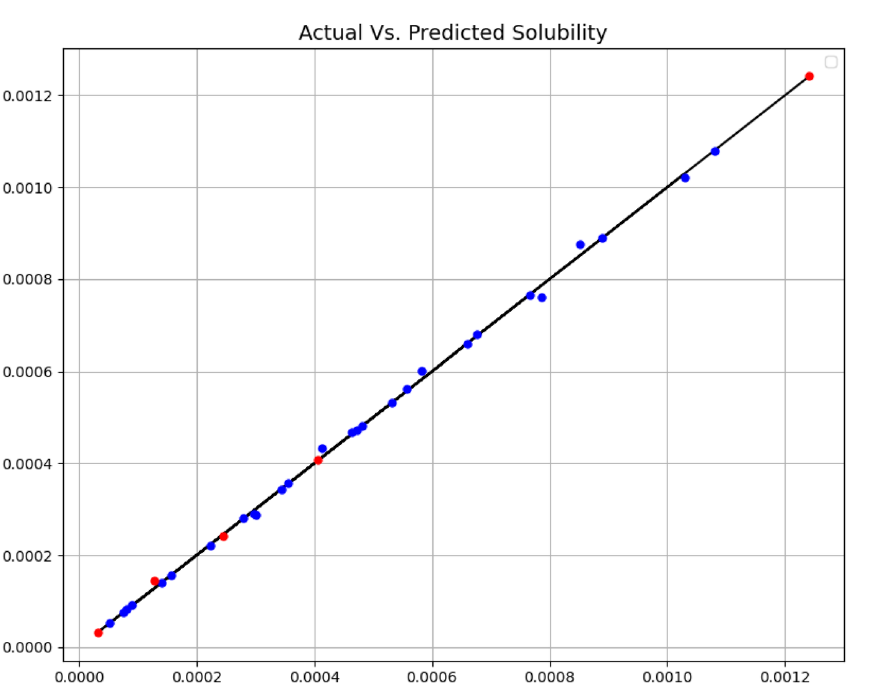
Figure 2. Expected and estimated values (ADA + GPR).